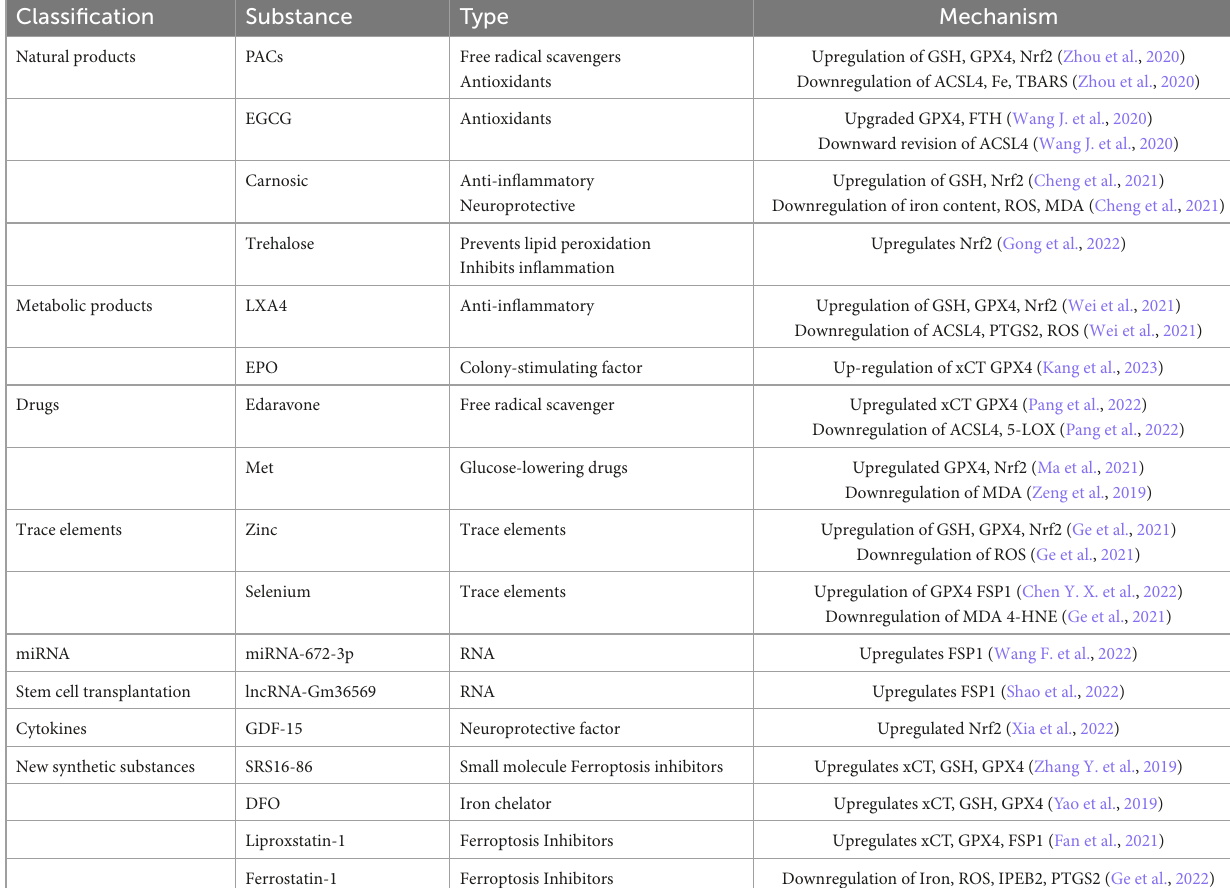
TABLE 1 Improvement of SCI-related substances through